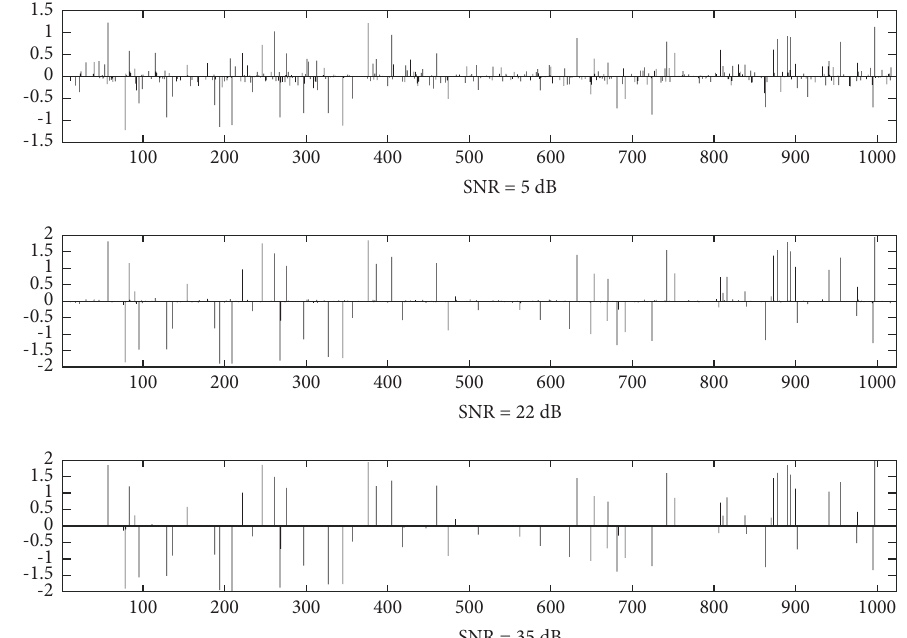
Figure 12: Recovering signals based on the SNR quality for the degraded signal with operator A